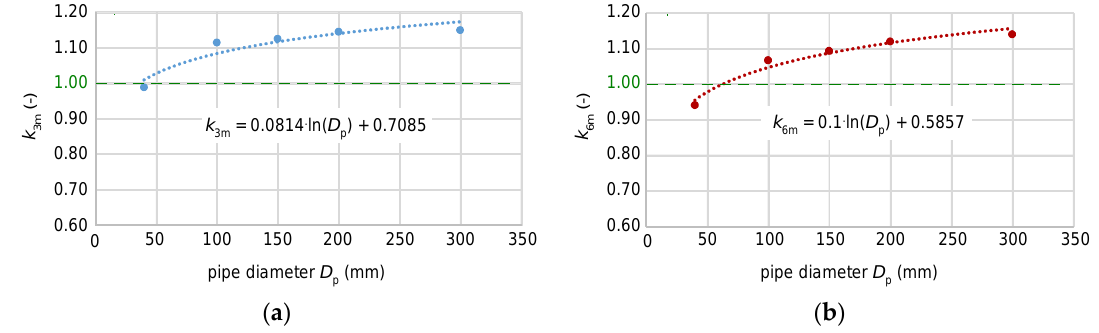
Figure 16. The current-carrying capacity correction factors k 3m and k 6m (as a function of the pipe internal diameter D p ) for the cable 35 mm 2 installed in the pipe of the length respectively: ( a ) 3 m; ( b ) 6 m.